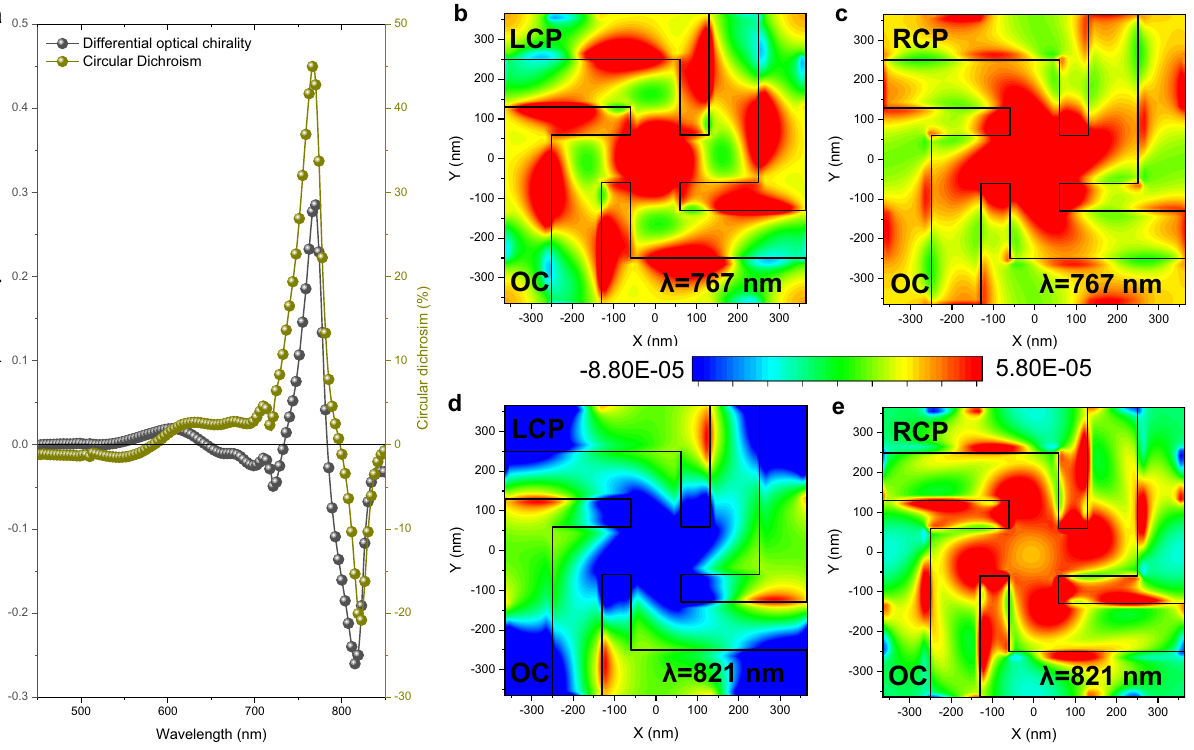
Fig. 3 Optical chirality of perovskite chiral metasurfaces. a Simulated differential optical chirality (integrated over the bottom surface) as a function of wavelength for a left-handed perovskite chiral metasurface, closely following the behavior of circular dichroism. b – e Color maps showing dissimilar spatial distributions of optical chirality for a left-handed chiral gammadion metamolecule at b 767 nm under LCP illumination, c 767 nm under RCP illumination, d 821 nm under LCP illumination, and e 821 nm under RCP illumination. All maps refer to the escaping surface upon which the light is